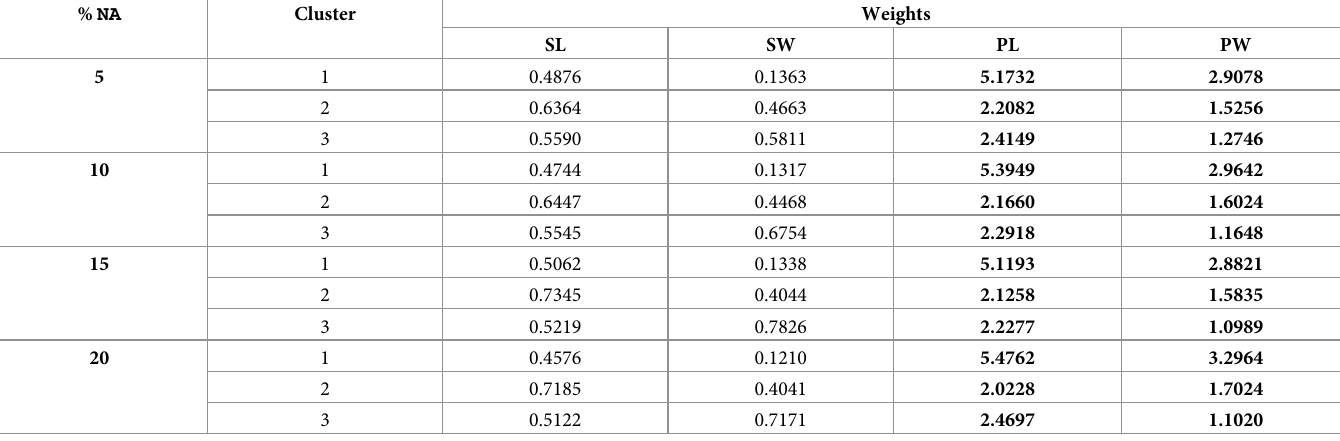
Table 5. Weights of the variables in each group adjusted by the VKFCM-K-LP algorithm with the OCS strategy under different percentages of missing values. % NA Cluster Weights SL